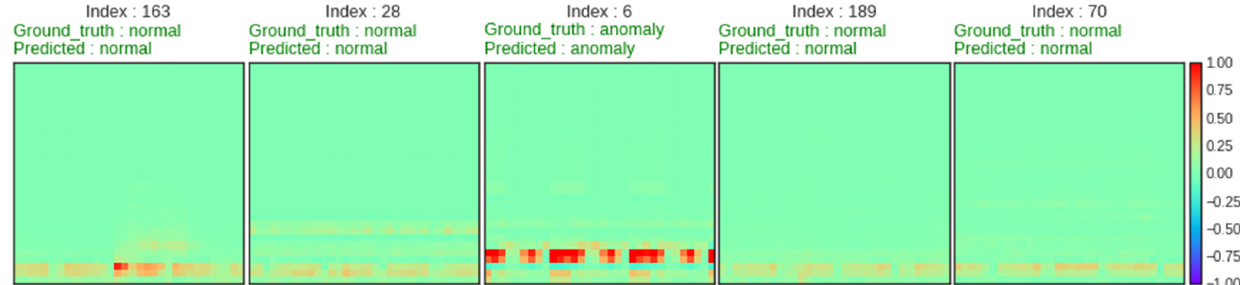
Figure 9. Slide rail data (8 K) STFT image encoding.